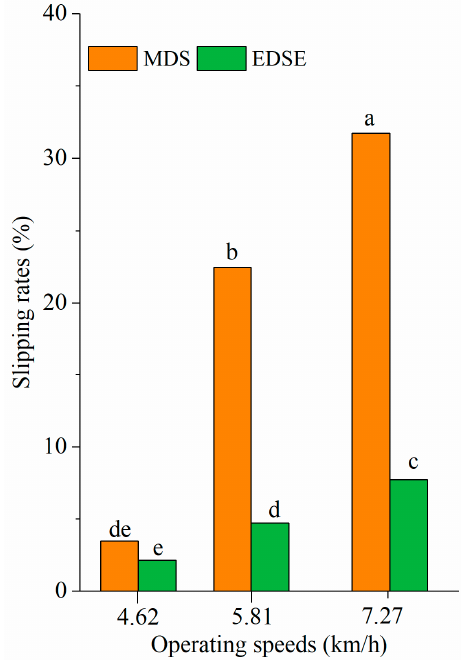
Figure 8. The slipping rates of the three driving systems at speeds of 4.62, 5.81, and 7.27 km·h − 1. . Different lowercase letters mean significant difference at the 0.05 level.